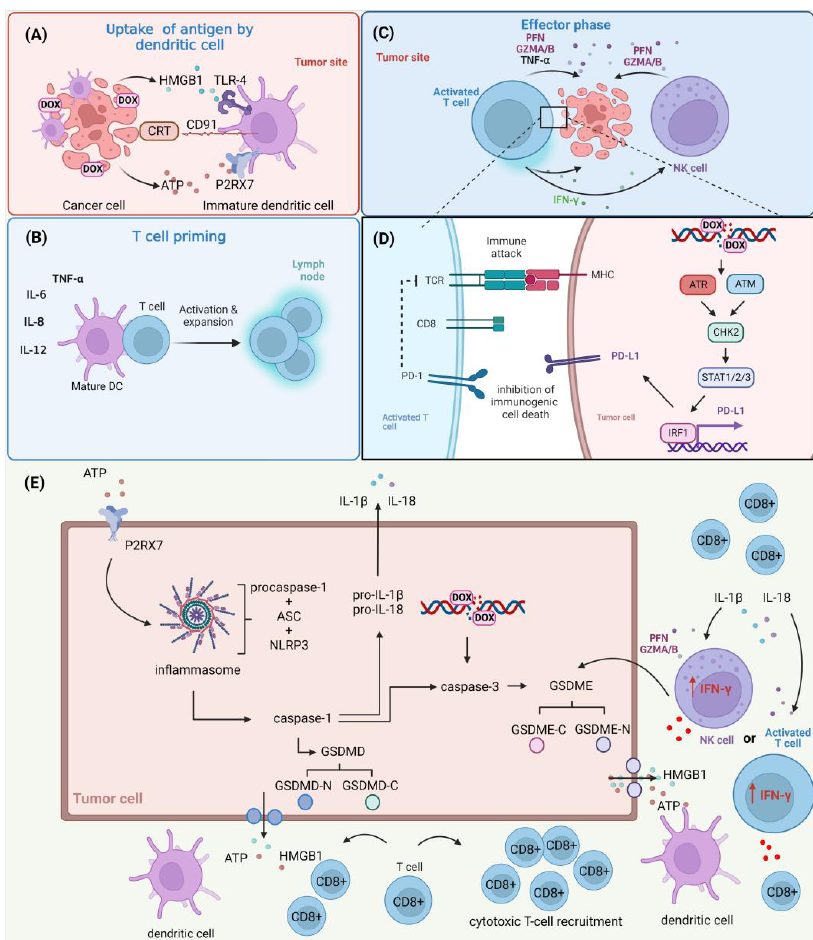
and promotion of higher cytotoxic T-lymphocyte responses after being activated by py- roptosis-induced signals [276]. The influence of DOX on the anti-tumor immune response is shown in Figure 3.